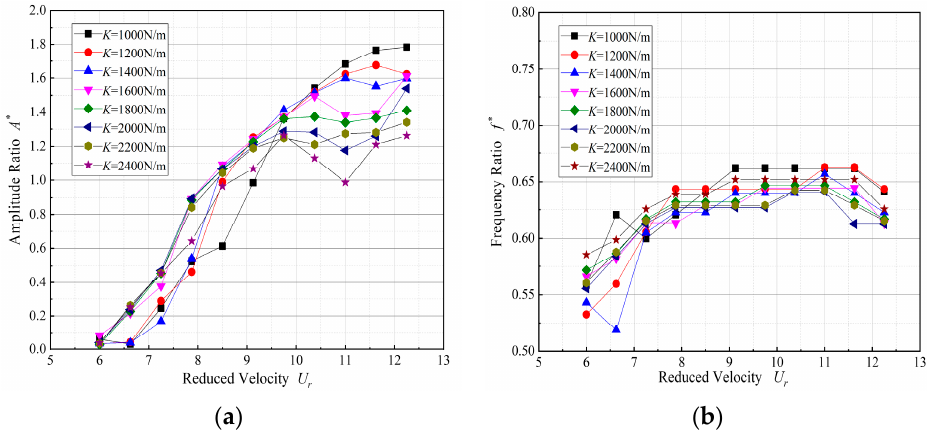
Figure 10. Amplitude and frequency response for different stiffness at L / D = 1.5. ( a ) Amplitude response; ( b ) Frequency response.